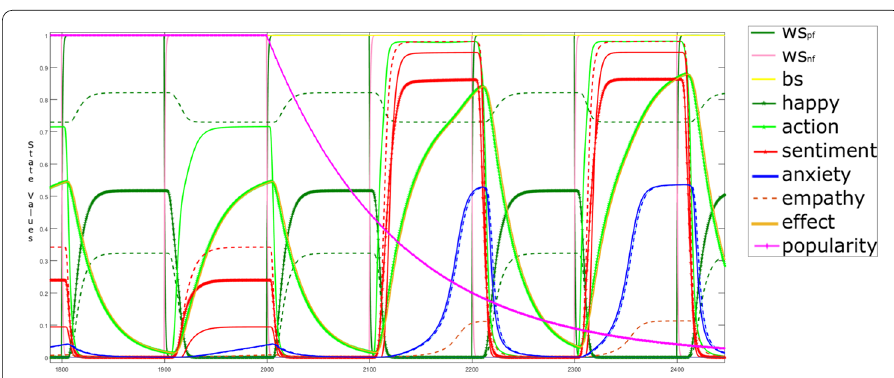
Fig. 7 Simulation of alternative episodes of ws nf